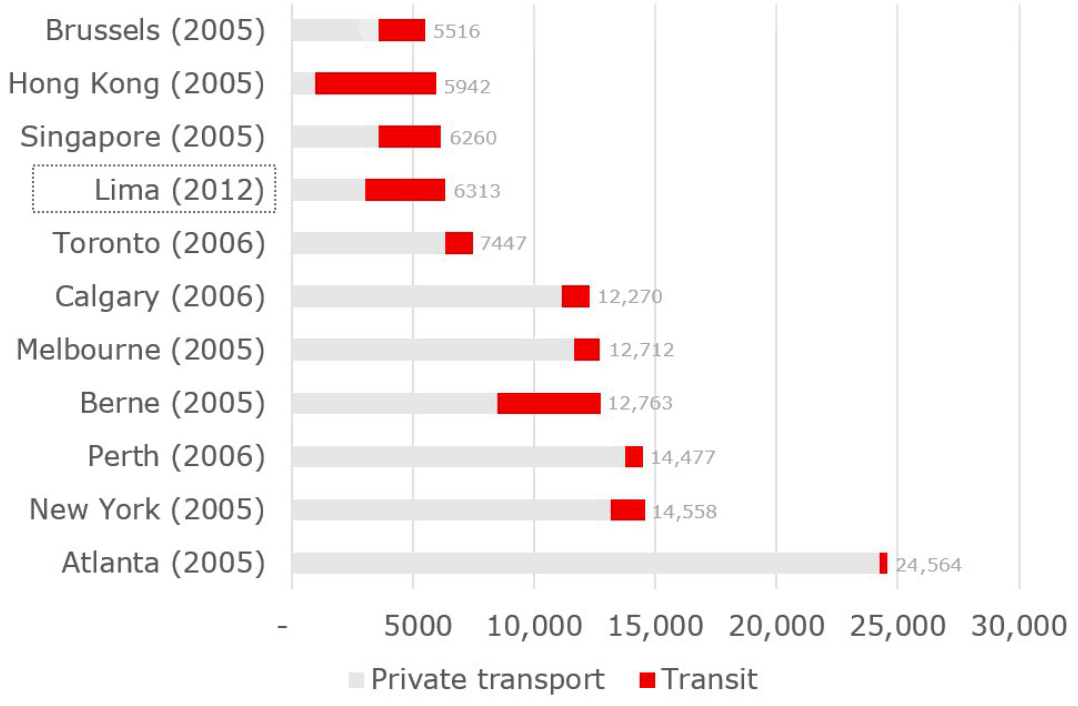
Figure 15. Total private and transit passenger kilometers per capita (passenger km/person) in world cities. Source: References [39,55,57,59,63]. Graph by authors.